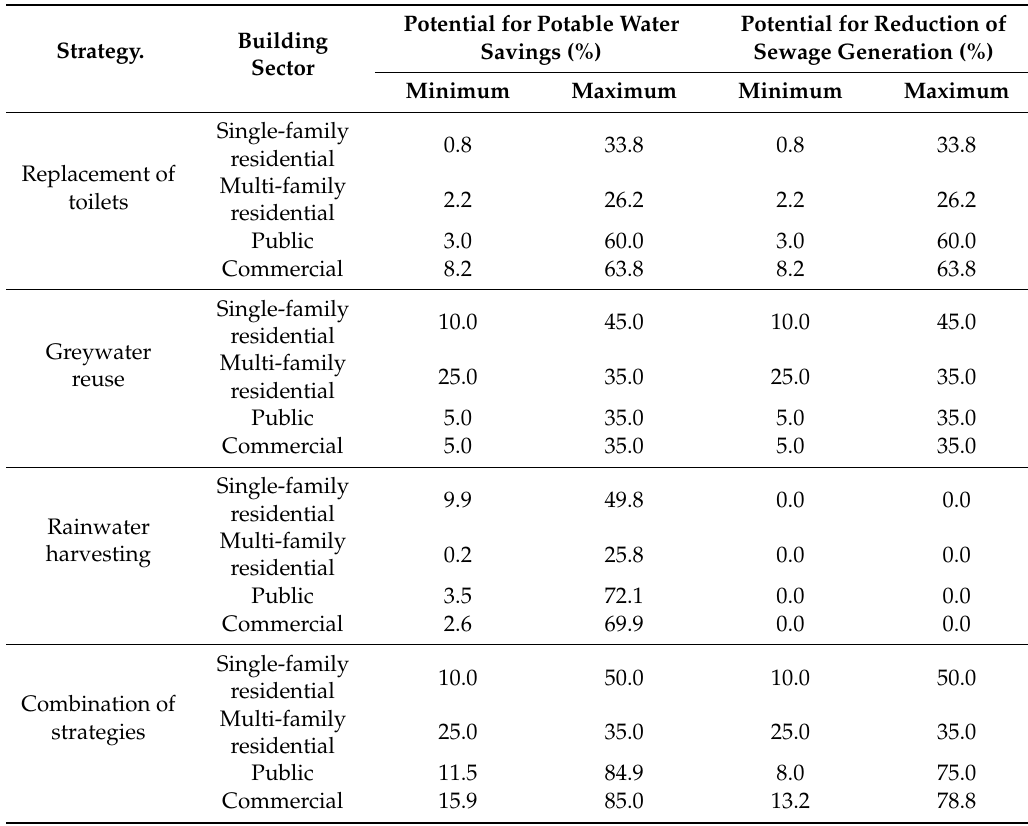
Table 2. Minimum and maximum potentials for potable water savings and reduction of sewage generation in each building